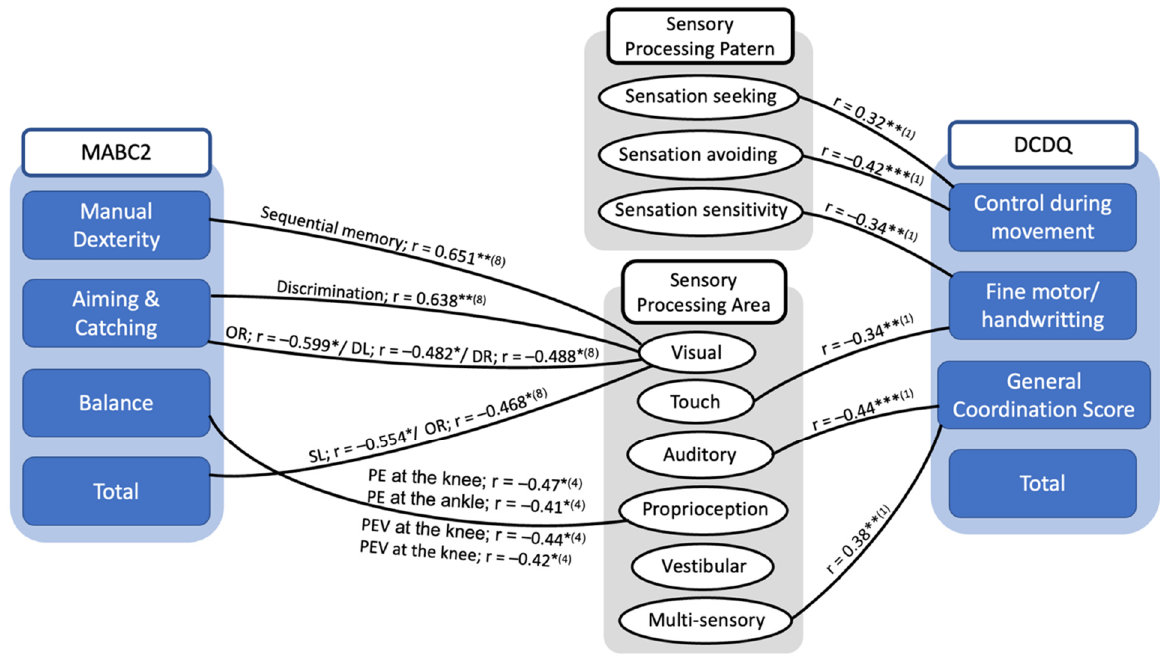
Figure 3. Summary diagram of the correlation between sensory processing and motor coordination in children with DCD. * p < 0.05, ** p < 0.01, *** p < 0.001; OR: double off in the right; DL: double left; DR: double right; SL: single in left in the sequential coupling of eye and hand. In this test, a yellow indication and three feasible target circles with the identical diameter of 10 mm were demonstrated on the screen at the left and right side of the midline individually, and the yellow indication was at the far left and far right locations. Three circumstances with two sides (left or right) were considered: single (one target), double (two targets), and double-off (two targets appeared, then disappeared) (abbreviated as SL, SR, DL, DR, OL, and OR, sequentially). (1); (4); (8): indicated the study in Table 3 showed information given in the